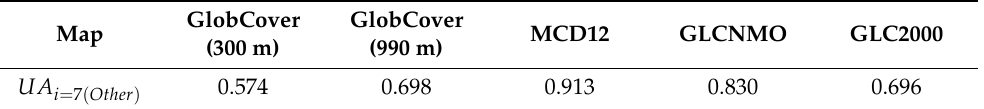
Table 14. Accuracy of non-uniformity